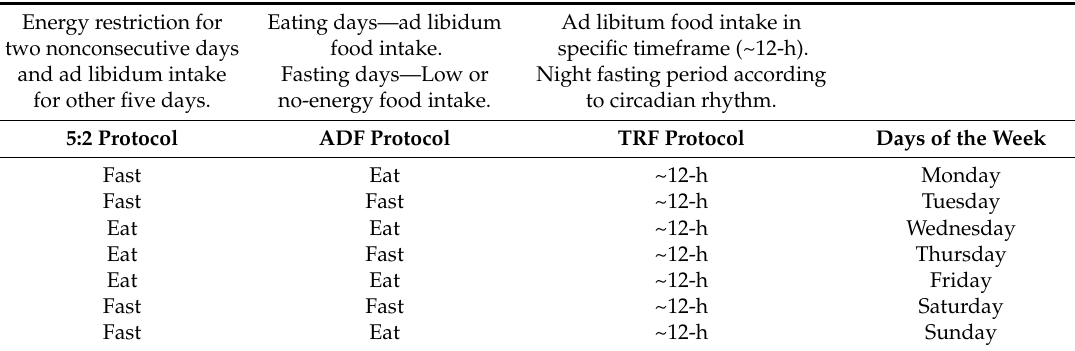
Table 1. Comparison of intermittent fasting protocols